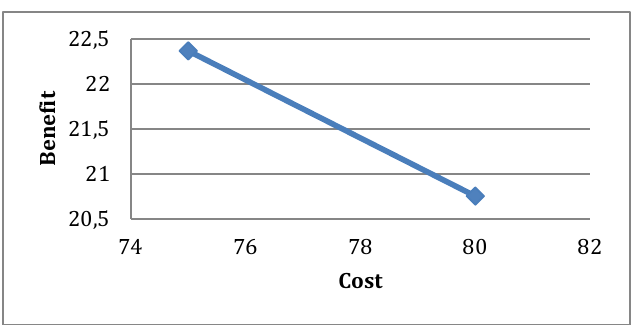
Source : Jiang, Zhang & Sutherland